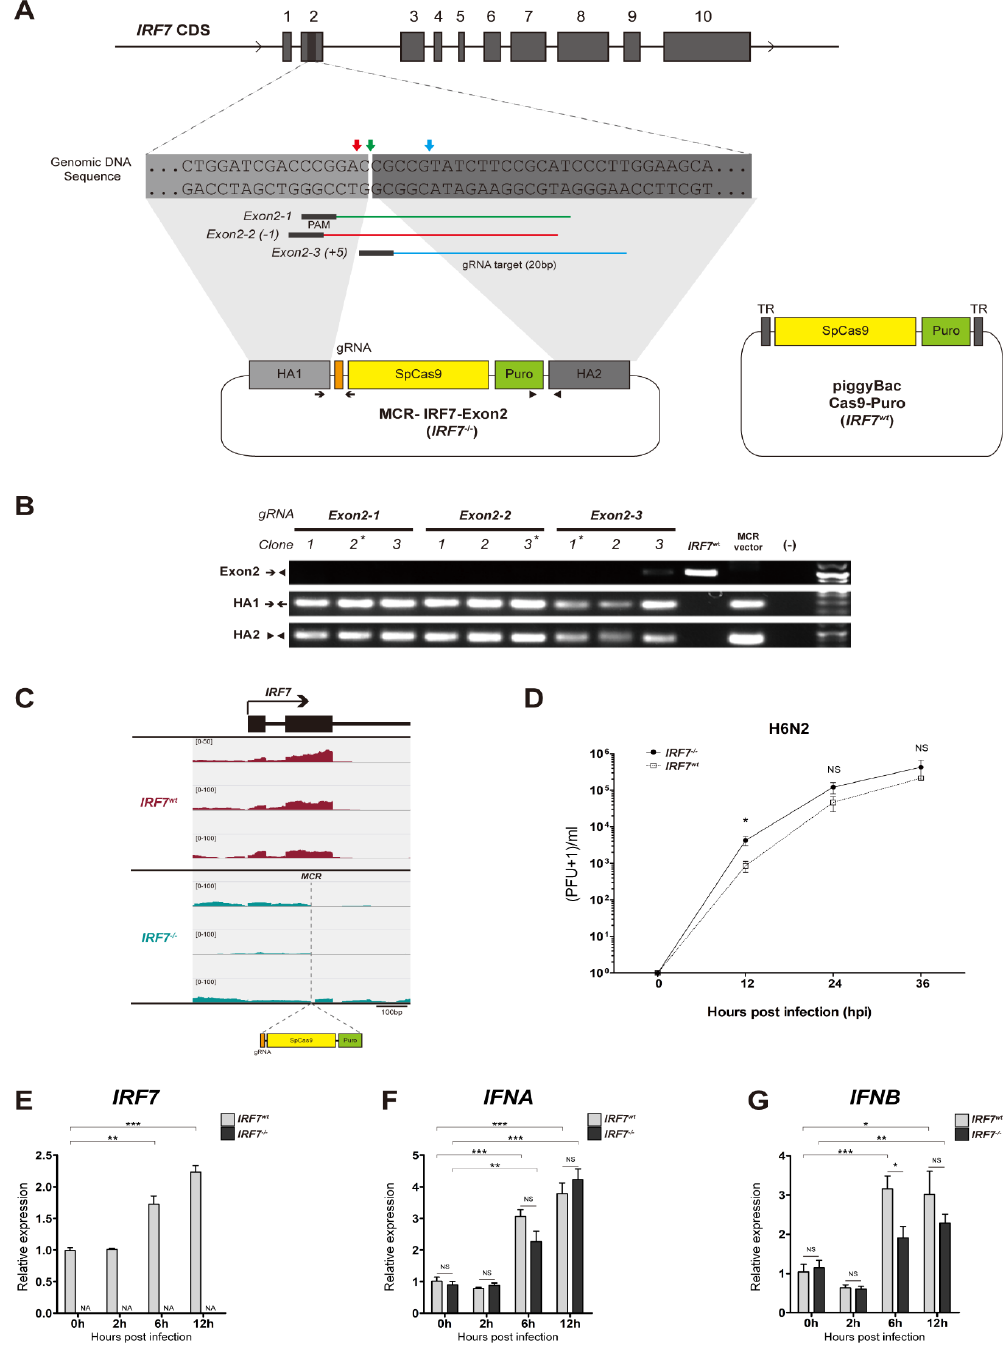
Figure 1. The establishment of IRF7 -/- and control ( IRF7 wt ) DF-1 cell lines. ( A ) Left panel: a scheme outlining the IRF7 knockout by the mutagenic chain reaction (MCR). An MCR plasmid targeting the second exon of chicken IRF7 was designed. Three adjacent guide RNAs (gRNAs) targeting the IRF7 exon 2 locus were selected, and each gRNA was cloned into the designed MCR plasmid. The locations of the PCR primers used for the analysis of the genomic insertion site are indicated. Right panel: the SpCas9-puromycin resistant gene construct from the MCR plasmid was cloned into the piggyBac transposon expression vector to generate control ( IRF7 wt ) DF-1 cells. ( B ) PCR analysis of bi-allelic MCR insertion cell clones for each gRNA is shown. The absence of a PCR band derived from the IRF7 exon2 locus (Exon2) and the presence of junctional bands corresponding to MCR insertion into the chromosomal IRF7 exon 2 locus (HA1, HA2) are shown for MCR cell clones. ( C ) RNA-seq alignment visualization of IRF7 wt (upper panel) and IRF7 - / - (lower panel) in non-infected cells (0